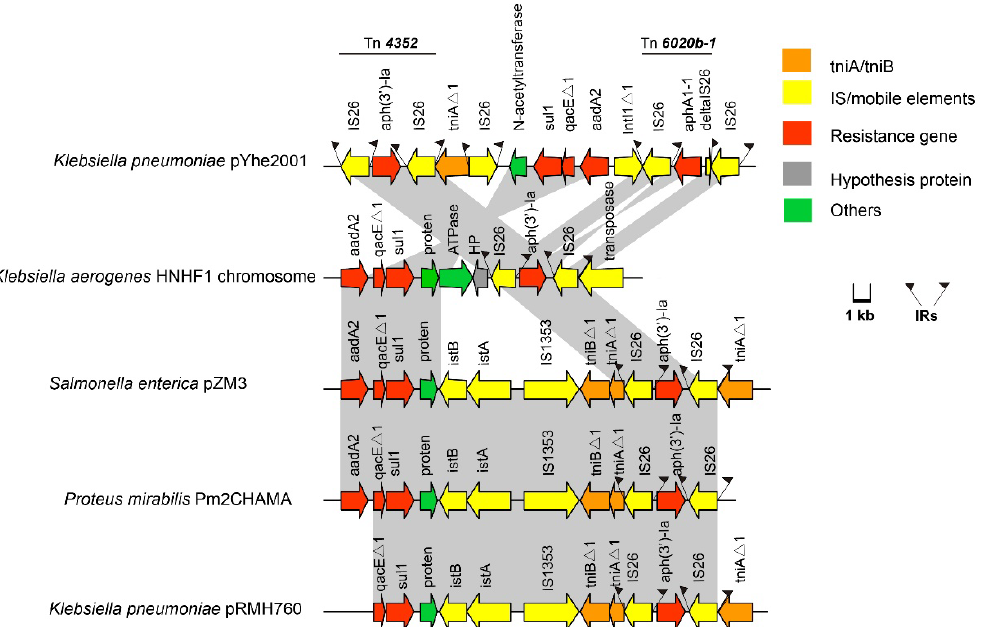
Figure 3. Organization of the Tn6897 transposon in the plasmid pYhe2001 and comparison with a similar structure. ORFs are shown as arrows, indicating the transcription direction, and the colors of the arrows represent different fragments. Intact ISs are represented by arrows, showing the direction of transcription of the transposase genes. Flags represent the IRs of ISs and transposons. Homologous gene clusters in different isolates are shaded in gray (>97%).